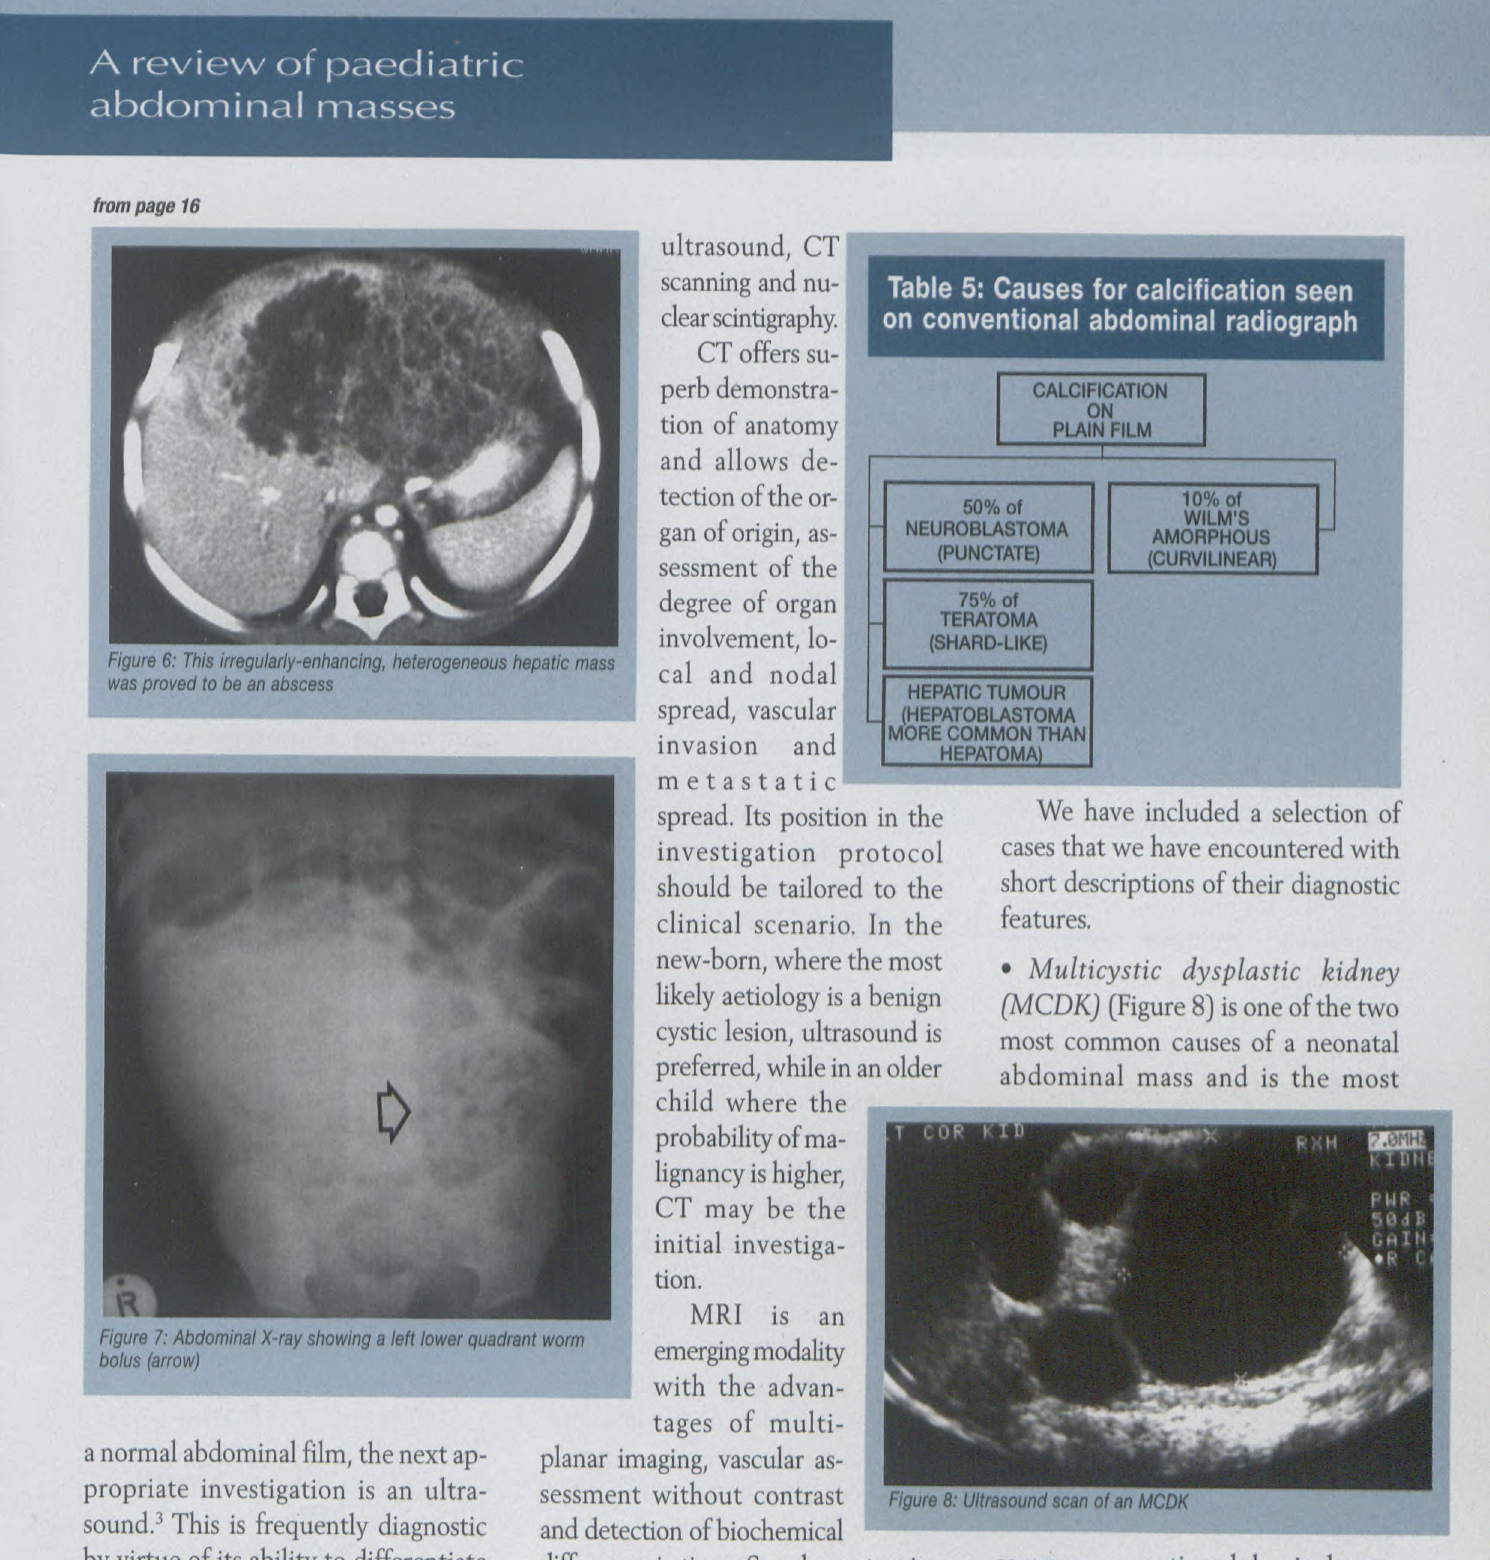
Figure 7: Abdominal X-ray showing a left lower quadrant worm bolus (arrow)